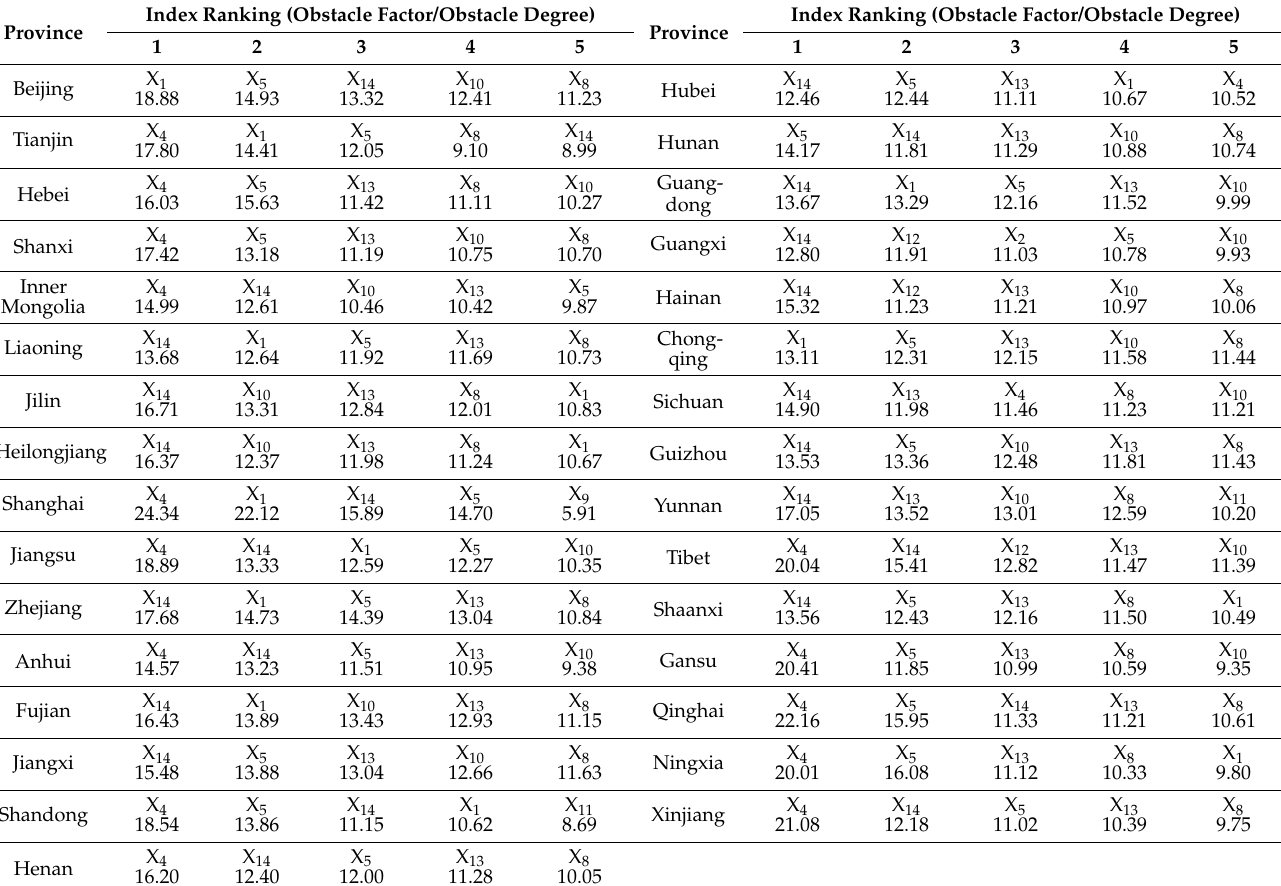
Table 4. The obstacle factors and obstacle degrees of FES of the 31 provinces